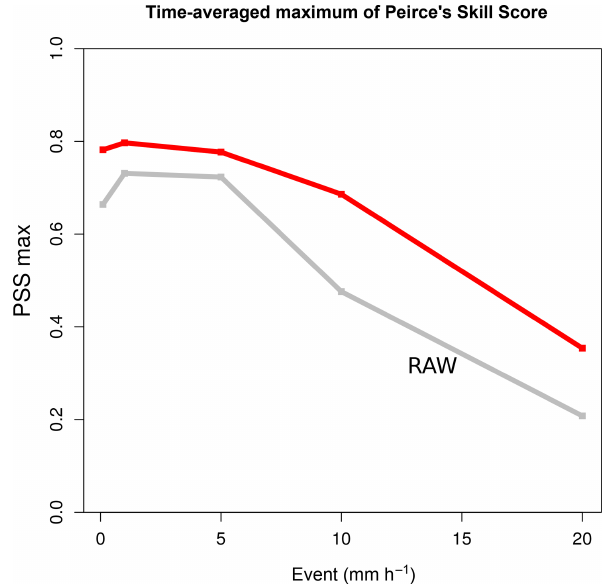
Figure 13. Maximum of the Peirce skill score among thresholds; the improvement is mainly due to the improvement of the hit rate. The validation is made by a 2-fold cross-validation on the 2 years of data (one sample per year).